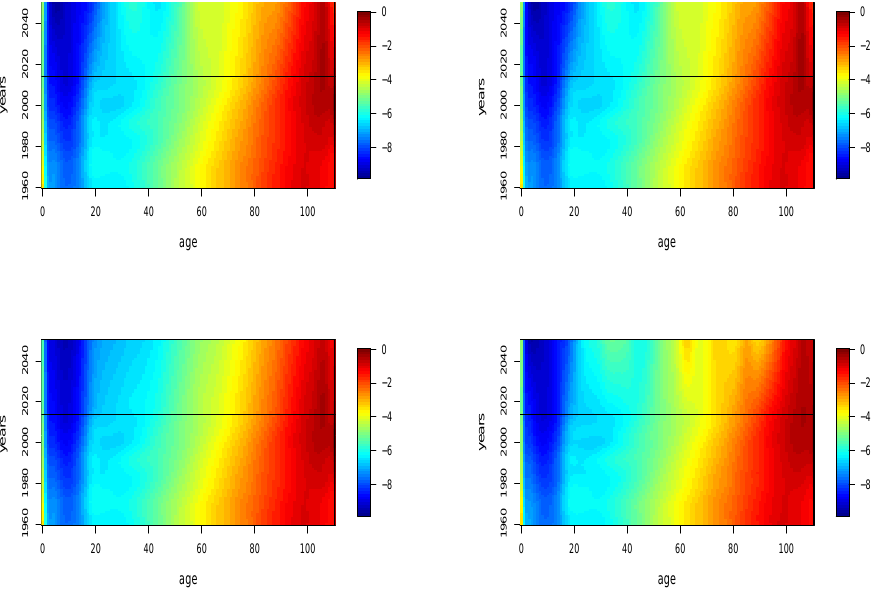
Figure 1. Fit and forecast of a data set on the log mortality rates of US males aged 0–110+ over the period 1960–2014, through model 1 ( top left ), model 2 ( top right ), model 3 ( bottom left ) and model 4 ( bottom right ). The horizontal line indicates the year from which we predict (2014).